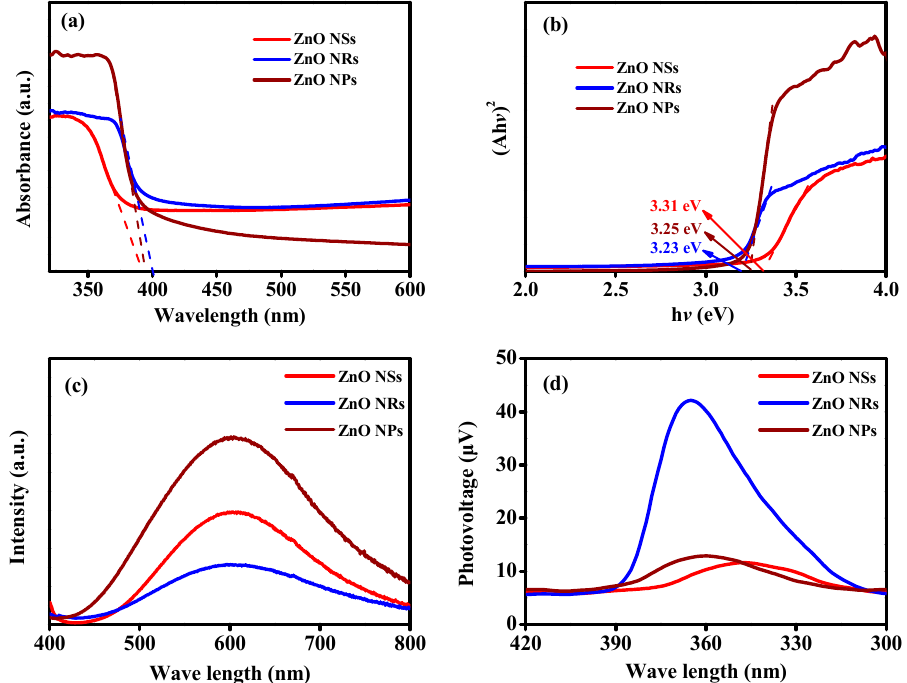
Figure 6. ( a ) UV-vis absorbance spectra, ( b ) the plot of (Ah ν ) 2 -h v , ( c ) SPV curves, and ( d ) PL curves of three ZnO samples.